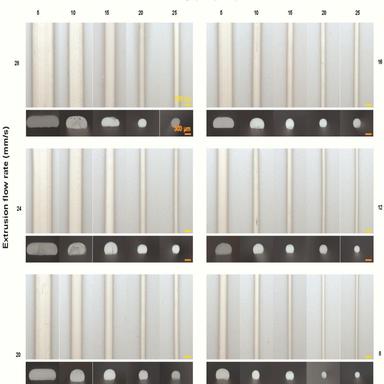
Characteristics of line width and cross-sections of lines printed at different printing speeds and different extrusion flow rates.